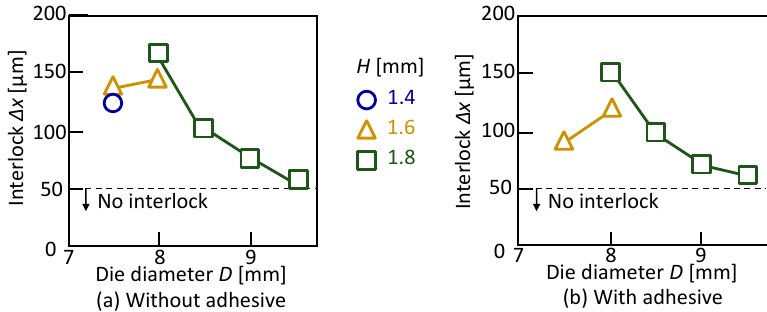
Figure 9. Effect of die shape on the interlock for L = 5 mm: ( a ) without adhesive; ( b ) with adhesive.